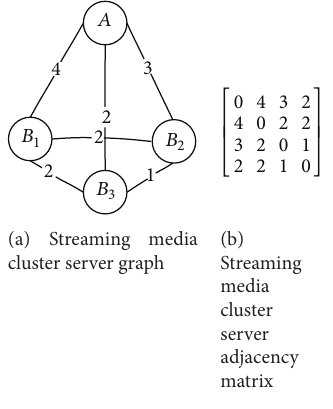
Figure 4: Cluster service graph and adjacency